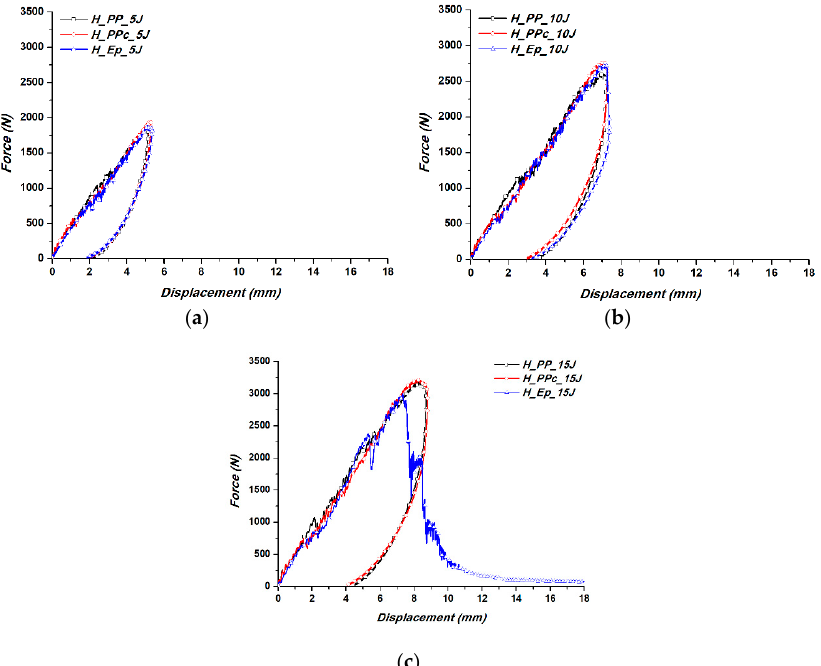
Figure 7. Typical force–displacement curves of flax/basalt hybrid composites at various impact energy levels: ( a ) 5 J; ( b ) 10 J, and ( c ) 15 J.